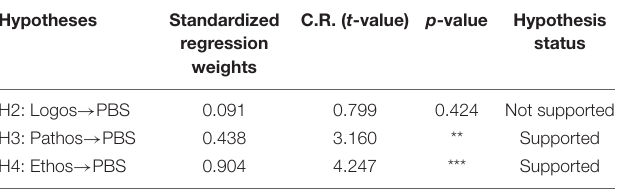
TABLE 6 | Results for research